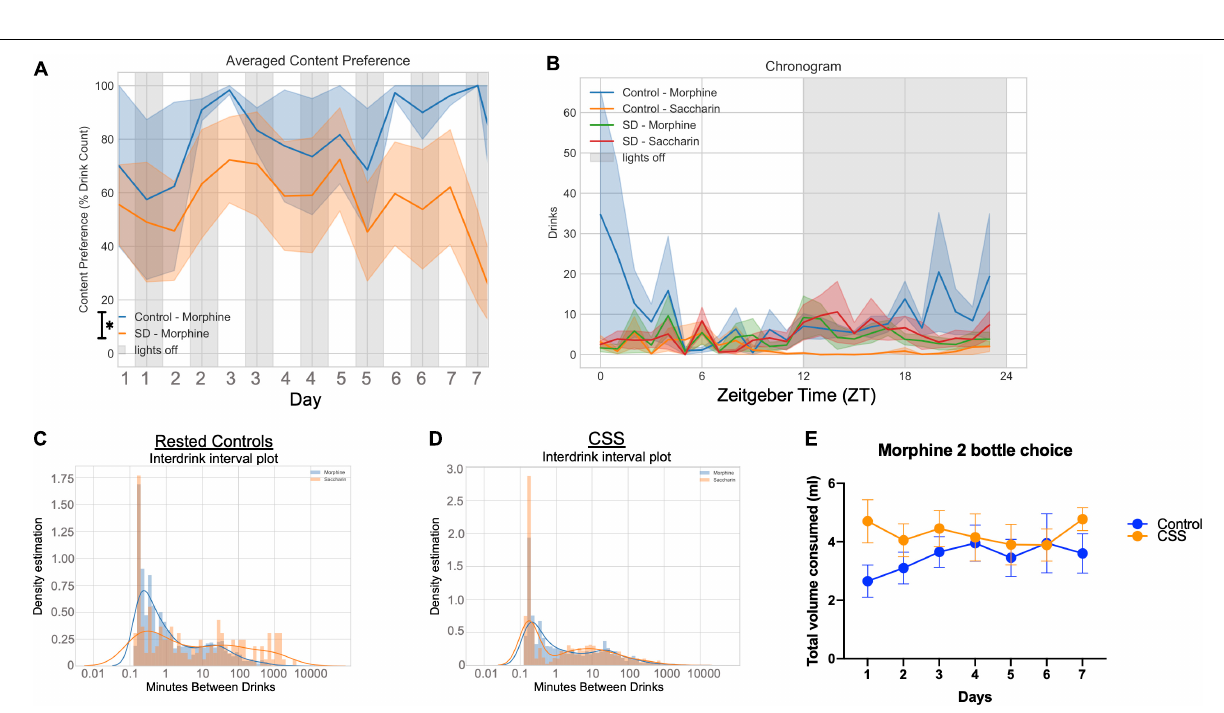
Frontiers in Neuroscience |